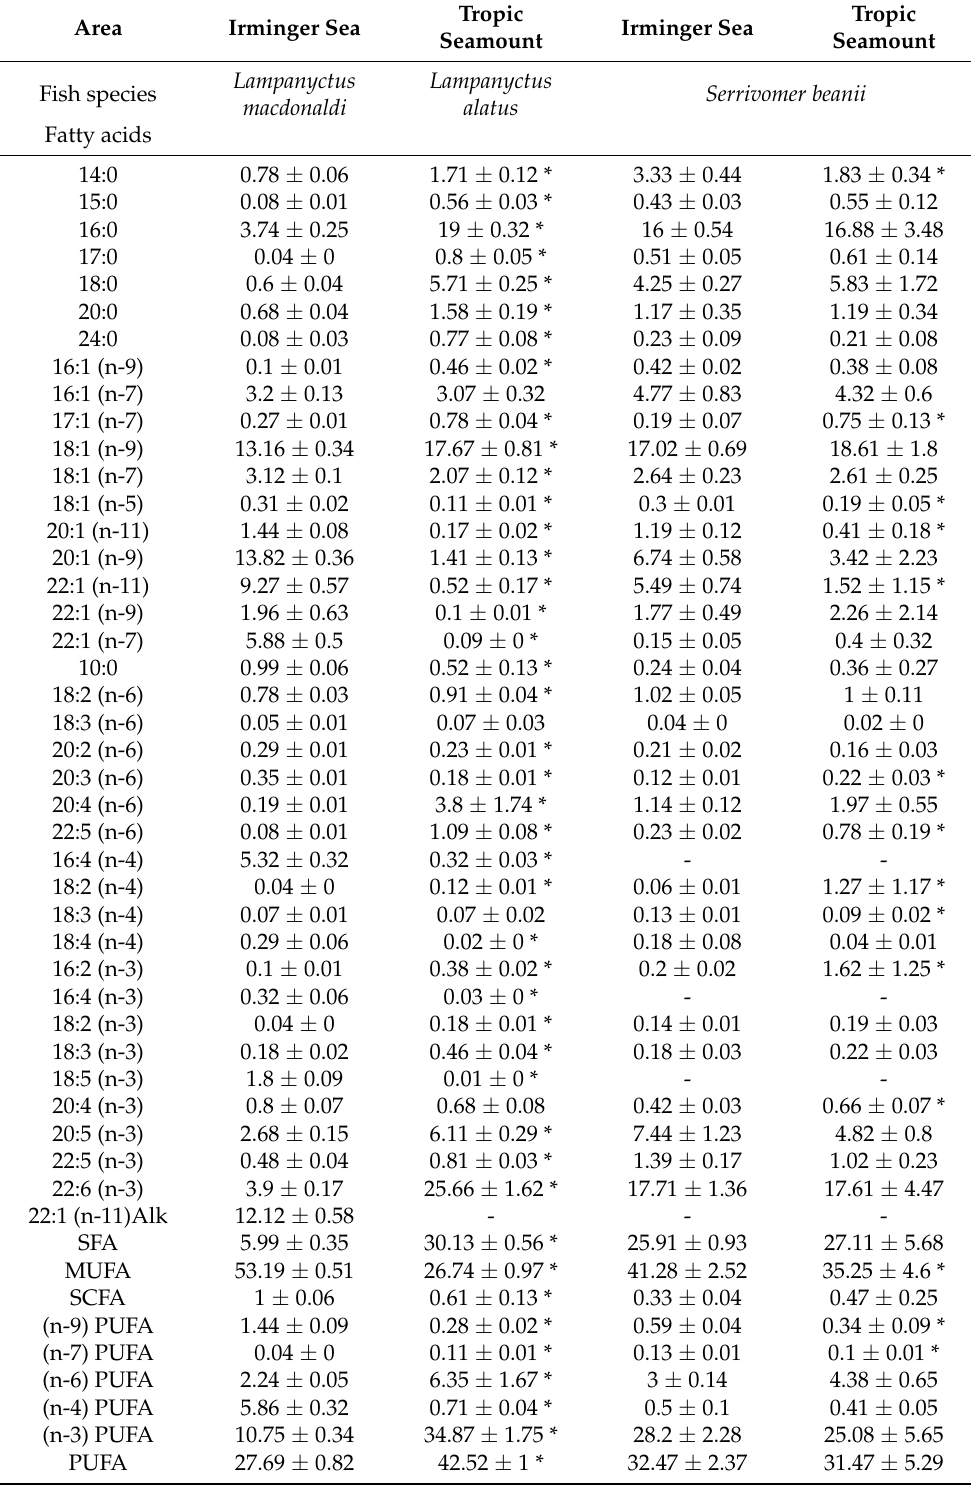
Table 3. Certain fatty acids (% of the total FA) in muscle tissue of mesopelagic fishes from Irminger Sea and Tropic